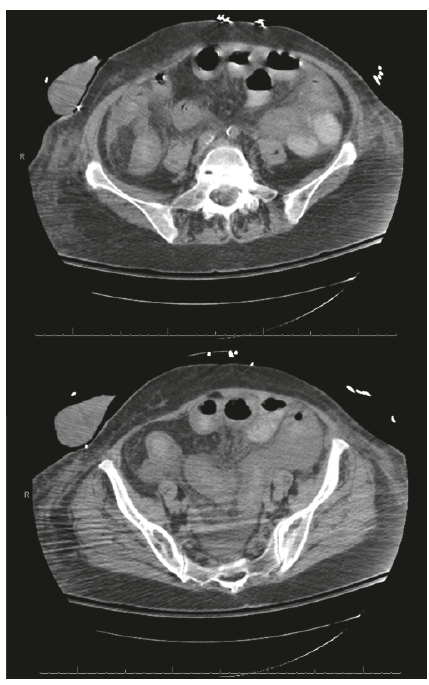
Figure 2: Second CT scan abdomen and pelvis two days later. Nonenhanced axial images showing diffuse small bowel dilation and intraperitoneal free